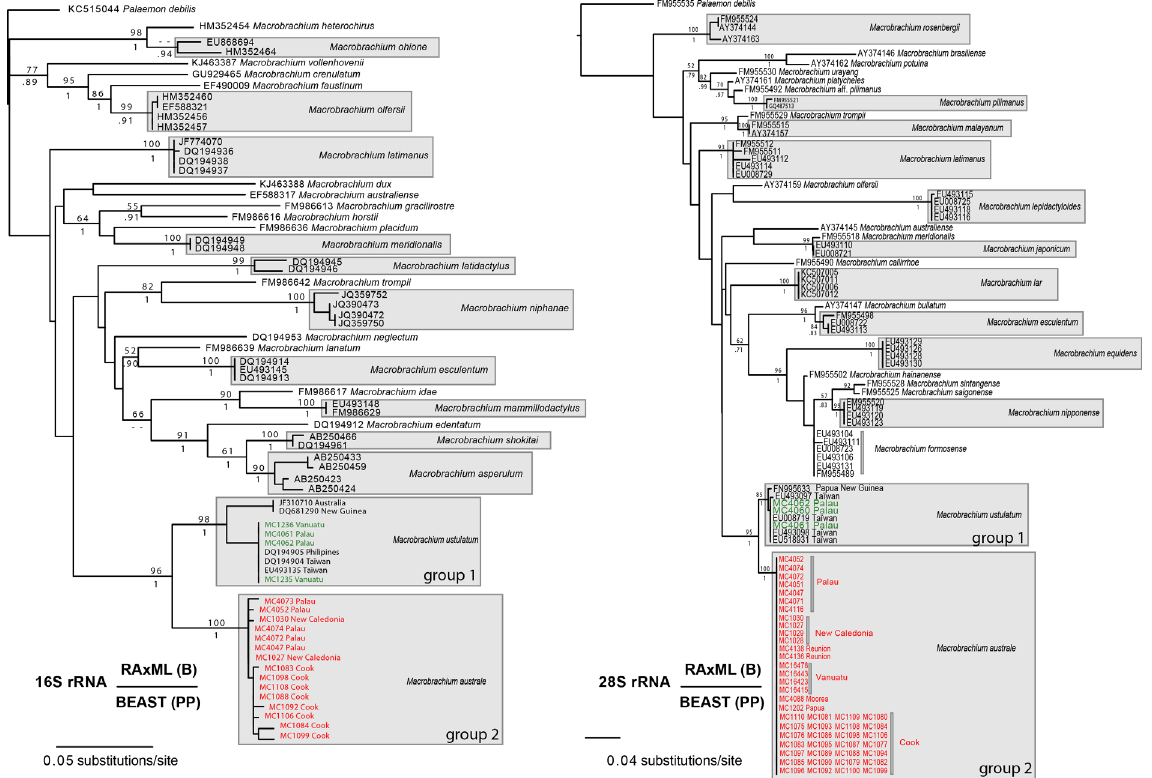
Fig. 2. Single-gene molecular phylogenies for Macrobrachium Spence Bate, 1868 based on the mitochondrial 16S and the nuclear 28S genes with Palaemon debilis Dana, 1852 as outgroup. Maximum likelihood (ML) and Bayesian (B) analyses, produced with BEAST and RAxML, respectively. Support values from Maximum likelihood and Bayesian analyses are posterior probabilities (PP) and bootstraps (B), respectively. GenBank accession numbers and working ID numbers are given at nodes. Species names are given on the right-hand side. The name of the sequences produced in the present study are colored in red for M. australe (Guérin-Méneville, 1838 in Guérin-Méneville 1829–1838) and in green for M. ustulatum (Nobili, 1899). For these, sampling locality are given at nodes. See Table 1 and Appendix for